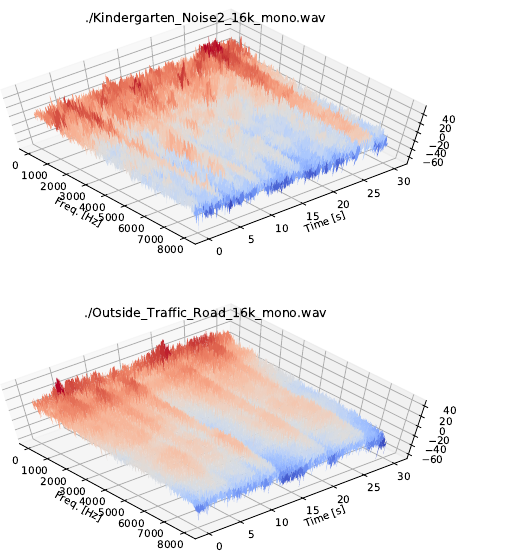
Figure 10. Test case 3: spectrogramms for the reference signals used in test case 3. Segments for the FFT were 2 10 samples long with a no-overlap segment of 2 8 samples.